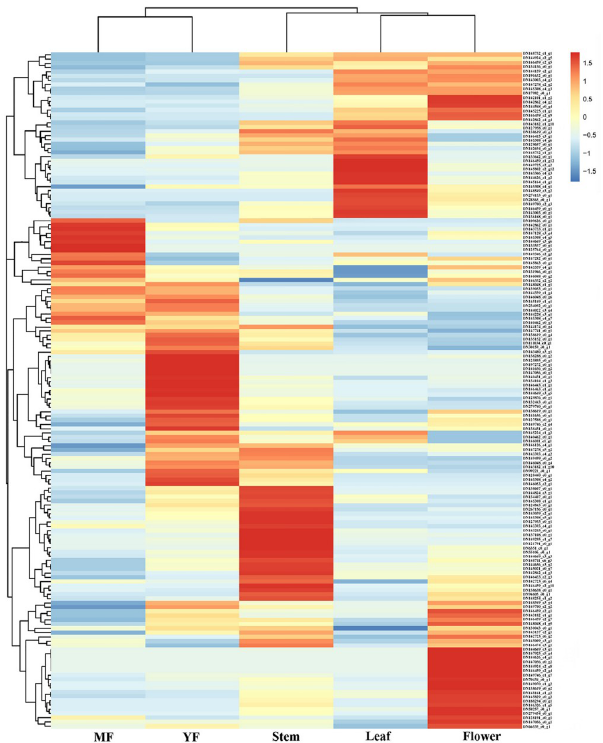
Fig 5. Heatmap and dendrogram indicating the expression levels of all MYBs using R software (version 3.1.3).